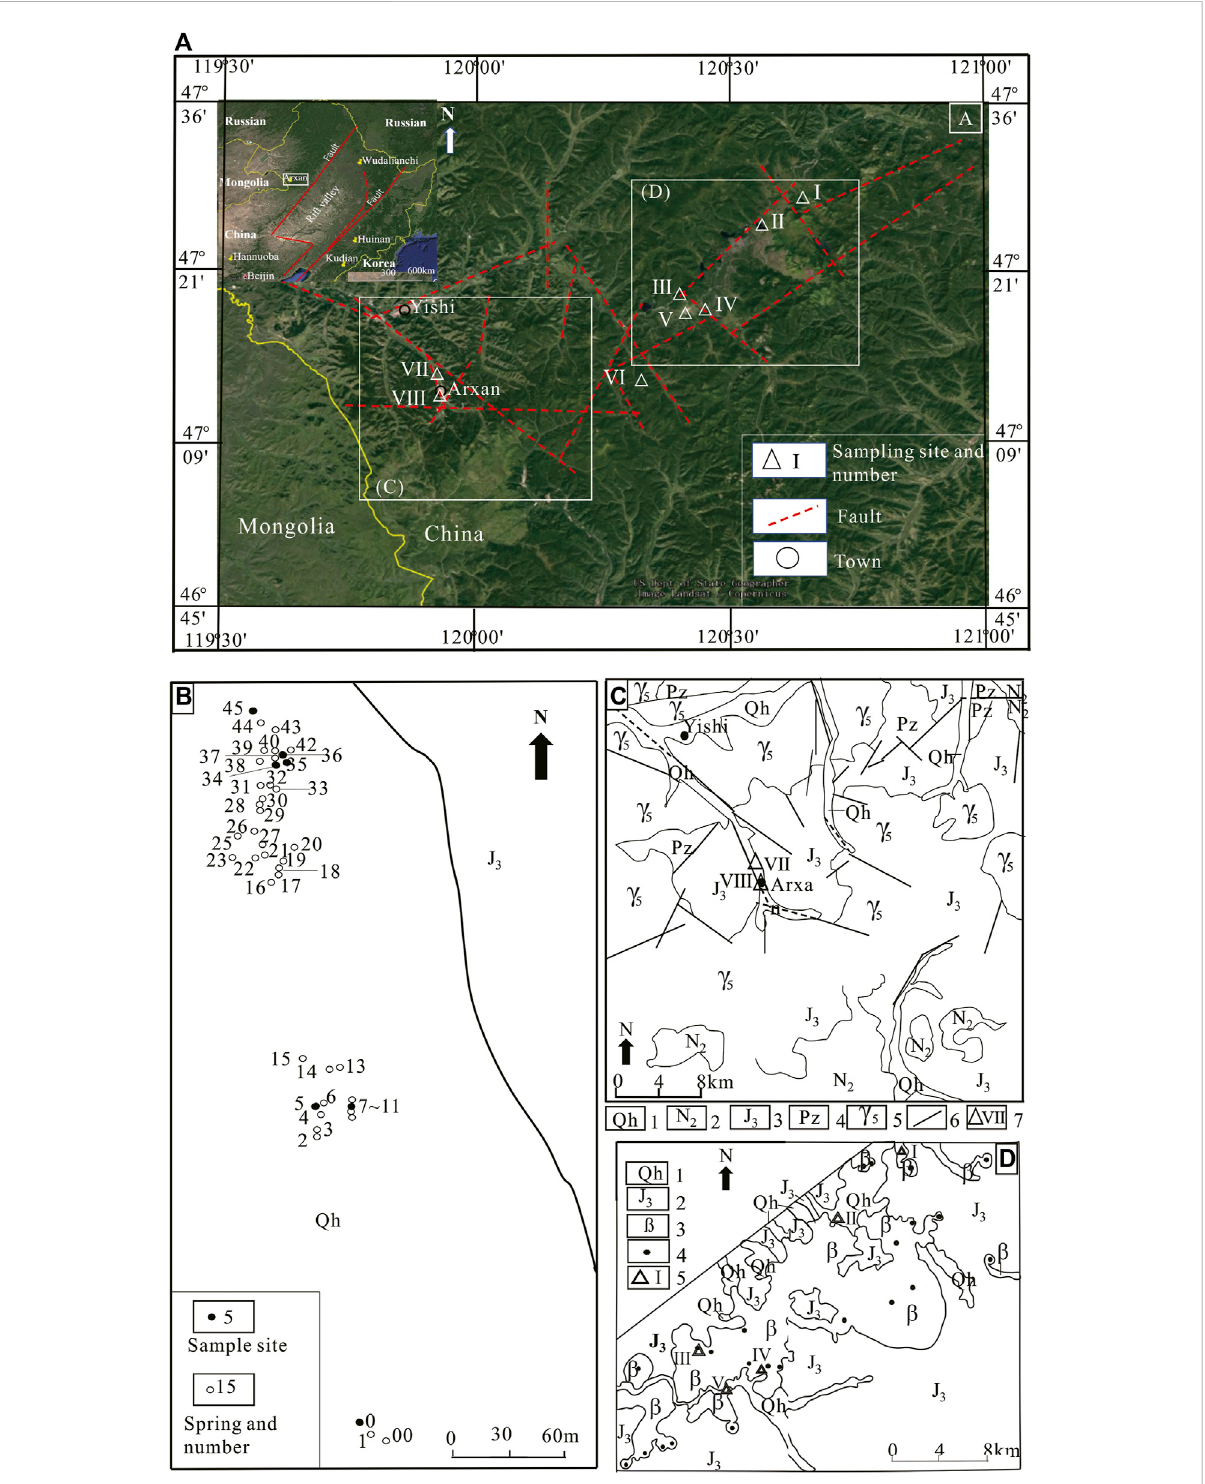
FIGURE 1 (A) Topography of the study area and vicinity, showing main faults and the sampling sites (the image from Google Earth); the inset of the DEM image shows the location of the study area; sampling sites: Ⅰ - Tuofengling; Ⅱ - Dujuanhu; Ⅲ - Tianchi; Ⅳ - Dichi; Ⅴ - Budonghe; Ⅵ - Jinjianggou; Ⅶ - Wuliquan; Ⅷ - the Hot Spring Museum. (B) Hot spring locations at the sampling site no. Ⅷ , 45 springs occur in an area of 700 m long from north to south and 70 m wide from east to west (modi fi ed after Zhang (2017)). (C) Geological map of the Arxan volcanic region (square C in A); 1 -